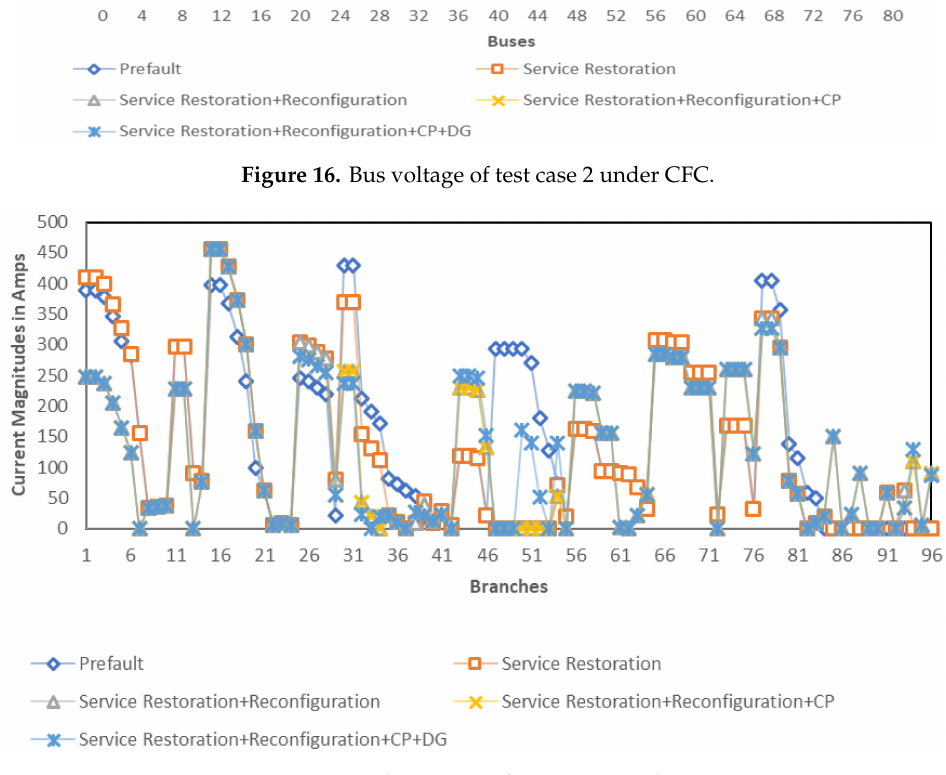
Figure 17. Branch currents of test case 2 under CFC. Table 10. Summary of results for test case 2 under CFC.